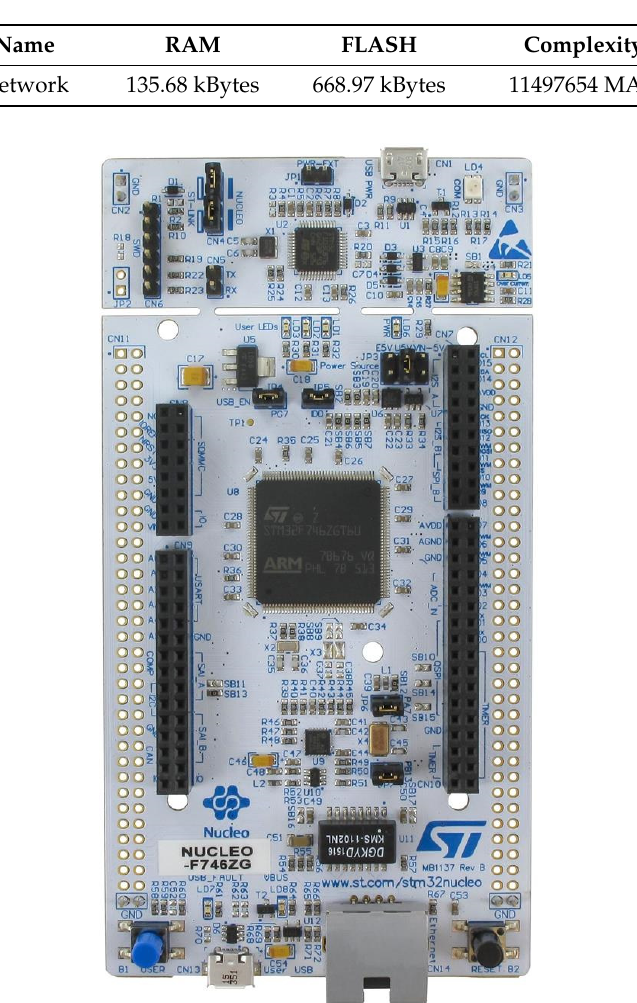
Figure 8. STMicrolectronics NUCLEO ‐ F746ZG. Table 6. Prediction of model on hardware.